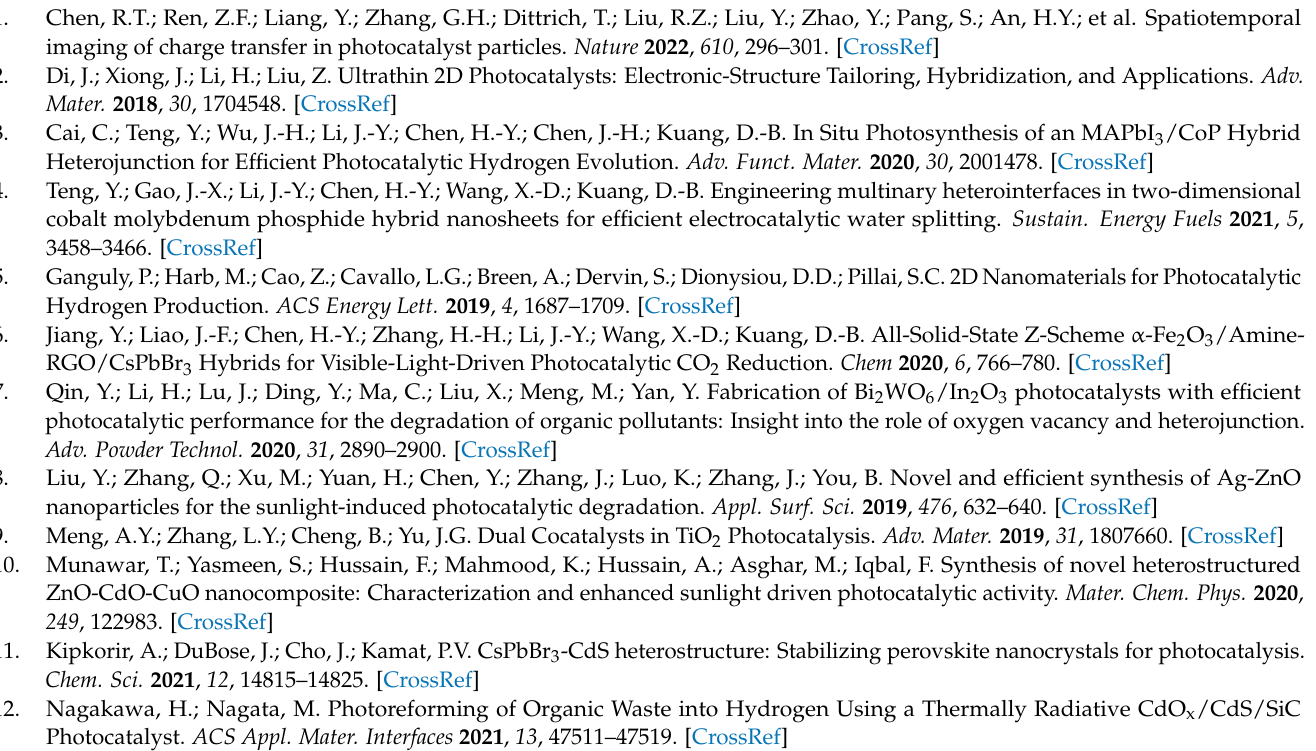
Figure S4: The relationship between time and H 2 production; Figure S5: Geometrical structure; Figure S6: Mott–Schottky plots; Table S1: Energy band structure parameters. References [53,58–67] are cited in the Supplementary